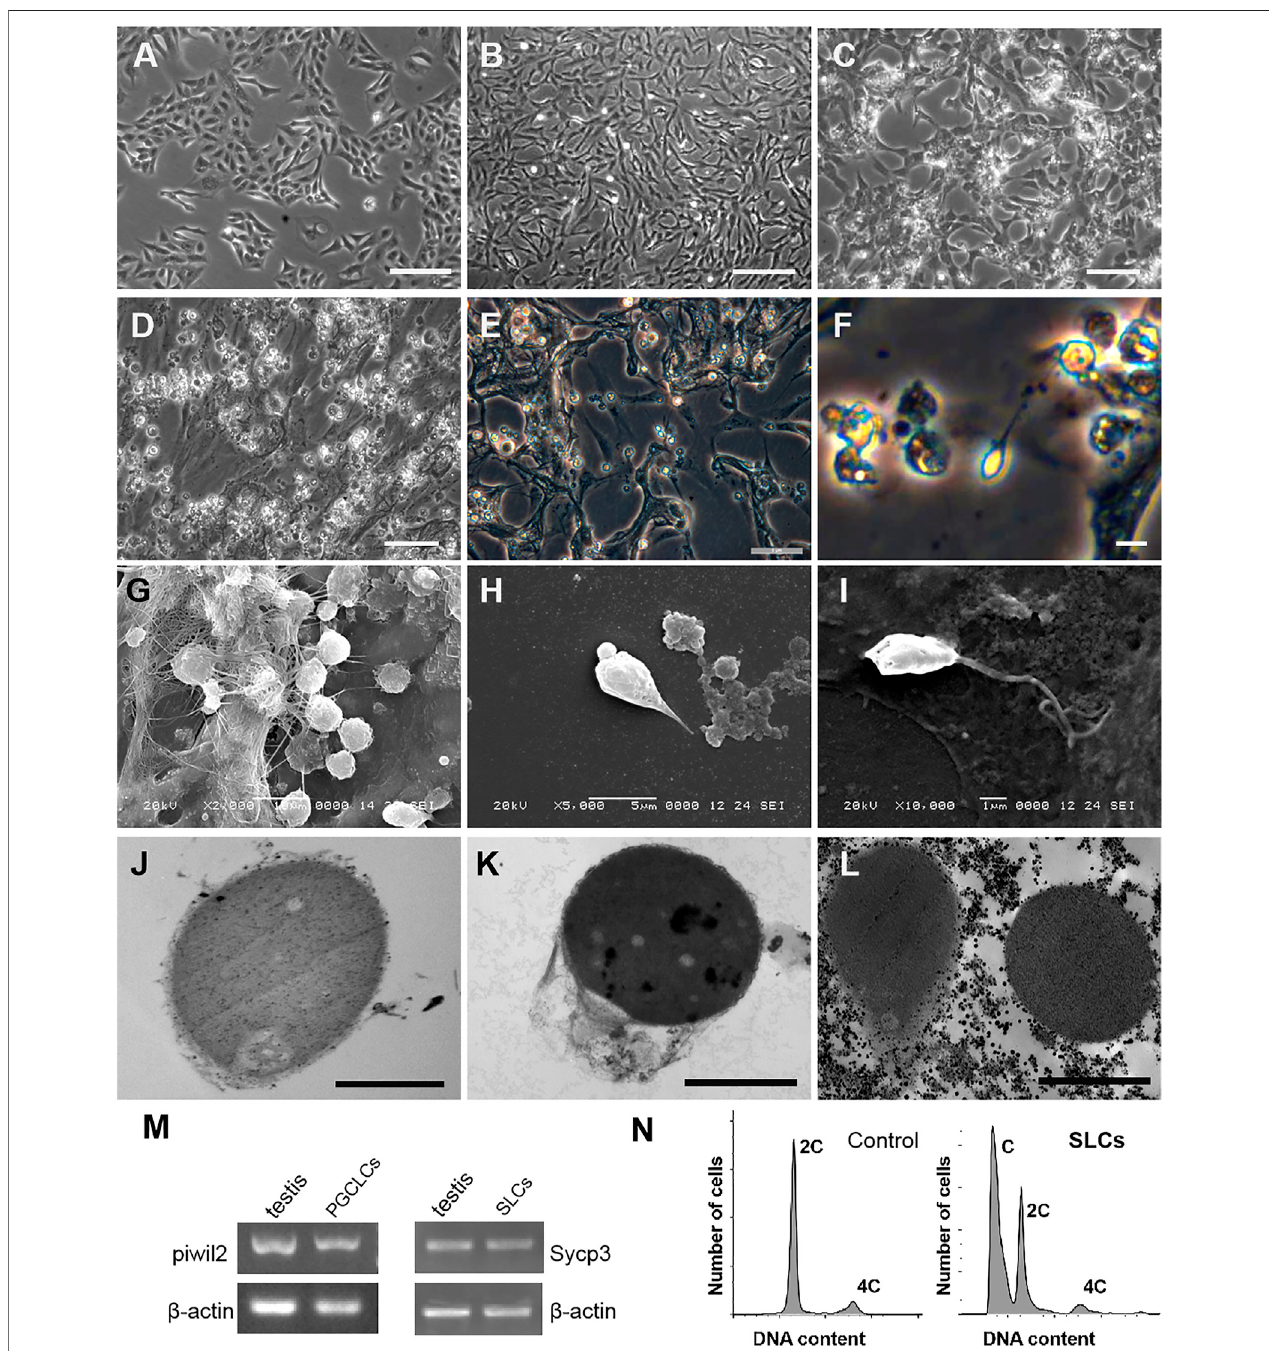
FIGURE 4 | Generation of germ cell-like cells from Kio-CiPSLCs. (A) Morphology of Kio-CiPSLCs. (B – F) Morphology of the induced cells. On day 3, the cells became long and narrow (B) ; On day 7, the cells enlarged and returned to a shape similar to that of stem cells (C) ; On day 11, the cells became smaller and a large number of small spherical cells appeared (D) ; On the day 20, sperm-like cells (SLCs) with long tails appeared (E,F) . (G – I) Morphology of the induced cells (day 20) was observed by scanning electron microscopy. A large number of sperm-like cells with small spheres and slender tails were observed. (J – L) Morphology of the induced cells (day 20) was observed by transmission electron microscopy. It has typical sperm cell morphology, such as nuclear condensation, cytoplasmic loss, and microtubule structure similar to sperm tail. (M) RT-PCR analysis of Piwil2 and Sycp3 expression levels in day 10 and day 18-induced cells. The cells form Kio testis as control. (N) Flow cytometry analysis of the day 20-dinduced cells. kFFs as control. A haploid peak appeared, indicating that Kio-SLCs have completed meiosis. (A – D) Scale bars, 20 μ m; (E – L) Scale bars, 5 μ m.